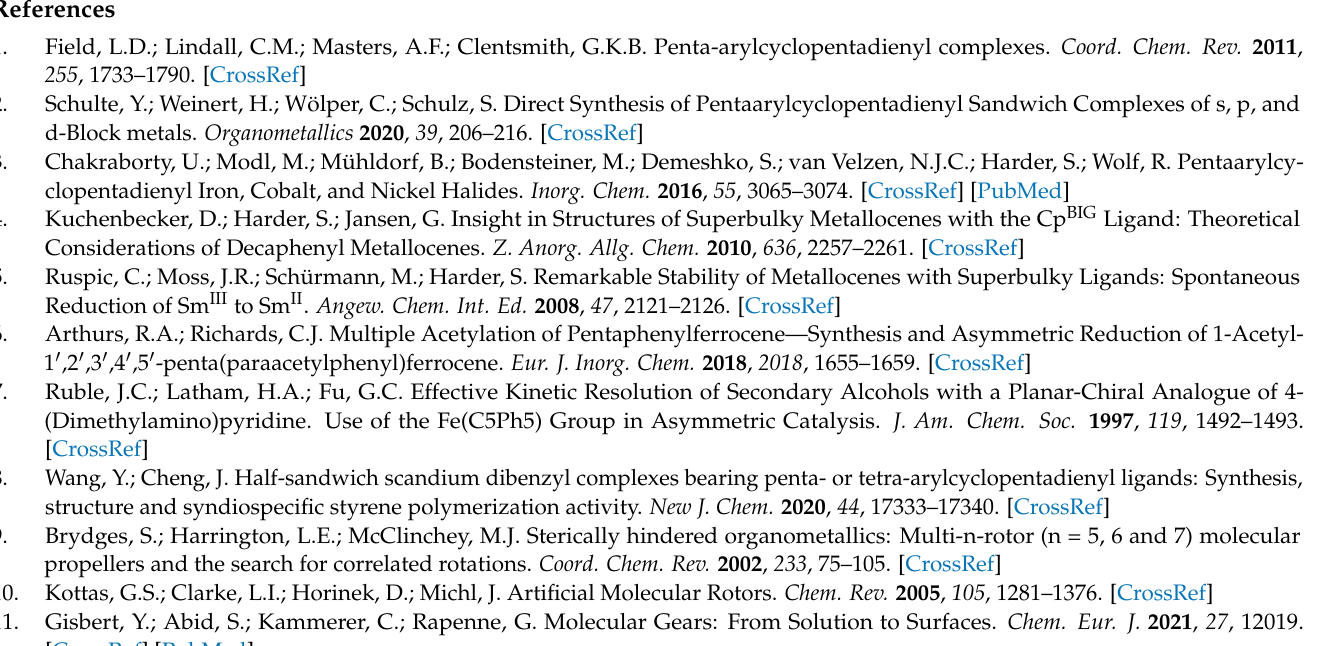
Supplementary Materials: Figure S1: 1 H-NMR spectrum (400 MHz) of 1 in CD 2 Cl 2 , phenyl region; Figure S2: 1 H- 1 H-COSY spectrum (400 MHz) of 1 in CD 2 Cl 2 , phenyl region; Figure S3: VT- 1 H-NMR spectra (400 MHz) of 1 in CD 2 Cl 2 , phenyl region; Figure S4: 13 C{ 1 H}-NMR spectrum (100 MHz) of 1 in CD 2 Cl 2 , 150 > δ > 70 ppm; Figure S5: DEI-mass spectrum of 1 ; Figure S6: UV-Vis spectra of 1 in CH 2 Cl 2 , at five concentrations; Figure S7: Hirshfeld surface of 1 ; Figure S8: CrystalExplorer fingerprint plot of 1 ; Figure S9: HOMO (left) and LUMO of 1 , as calculated by CrystalExplorer ; Figure S10: PLATON cavity plot for the unit cell of 1 ; Table S1: Experimental Details of the Structure determina- tion; Table S2: C–H...C( π ) interactions in the [C 5 Ph 5 ] ligand of 1 ; Table S3: C–H...C( π ) interactions in the [C 4 Ph 4 ] ligand of 1 ; Table S4: C–H...C( π ) interactions between the [C 5 Ph 5 ] and [C 4 Ph 4 ] ligands of 1 ; Table S5: C–H...CT( π ) interactions in 1